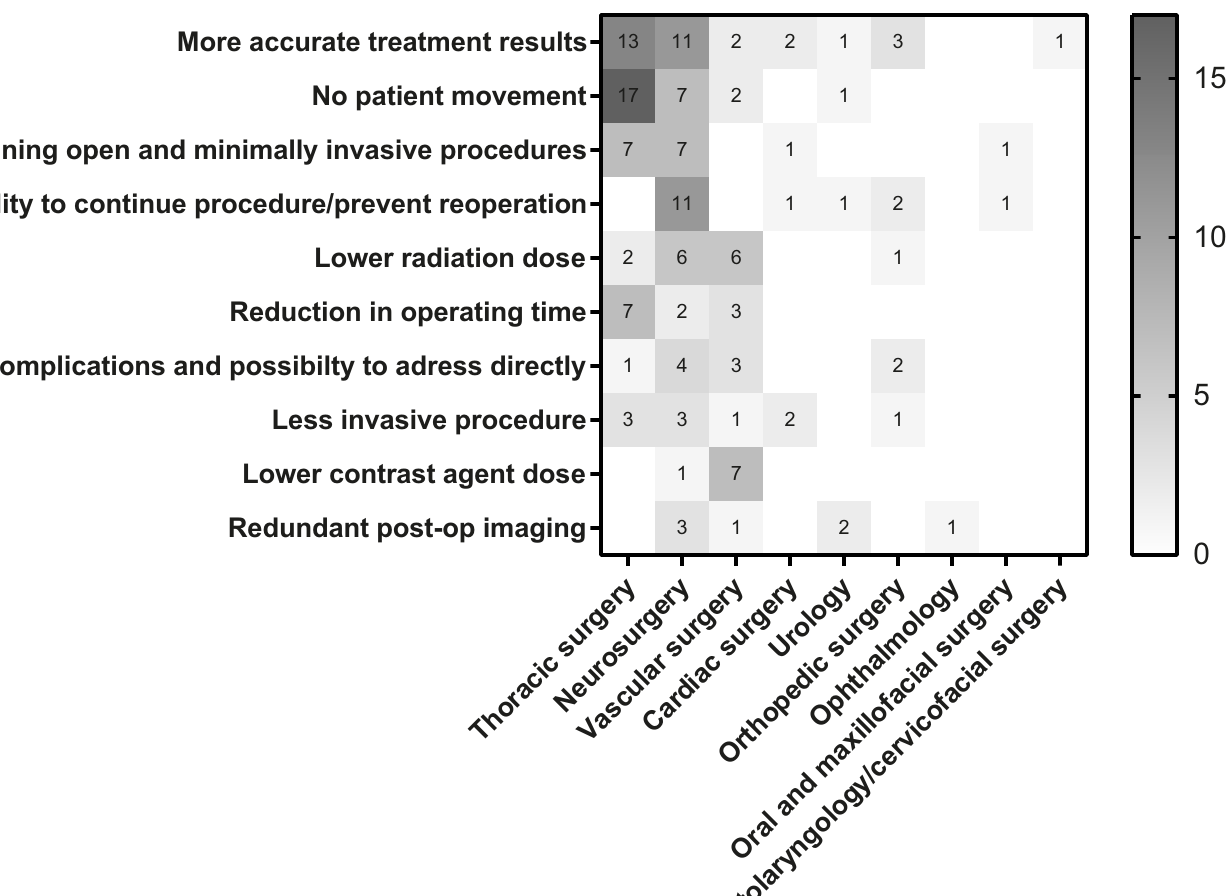
PLOS ONE | https://doi.org/10.1371/journal.pone.0266341 April 1,